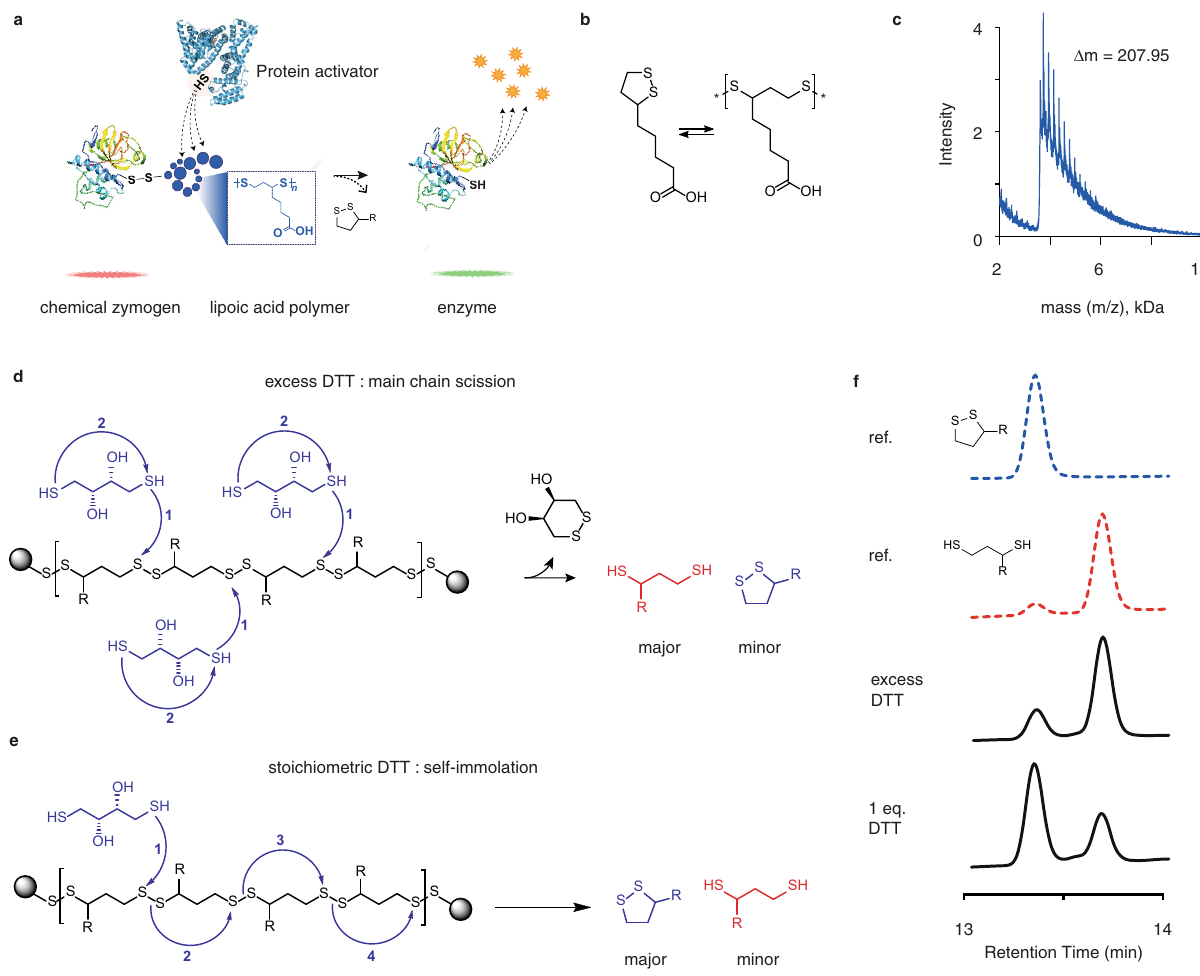
of depolymerization for LA PDS via main-chain scission ( d ) or self-immolation ( e ), depending on stoichiometry of added reducing agent; f reference HPLC traces of oxidized and reduced lipoic acid monomers, and experimental data on depoly- merization of LA PDS in excess DTT and with equimolar DTT, illustrating main- chain scission or self-immolation as predominant mechanisms of depolymeriza- tion, depending on stoichiometry of